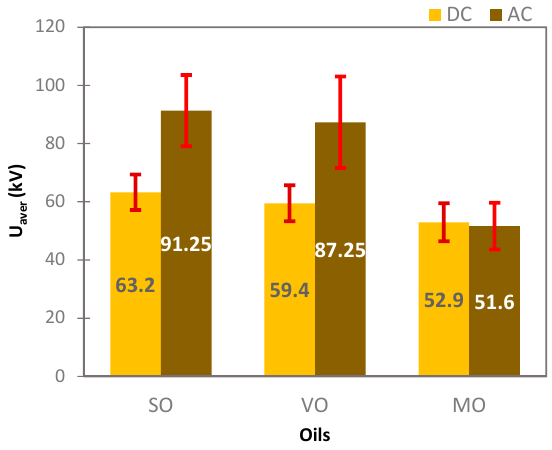
Figure 5. Average breakdown voltage of oils alone; the bars indicate the standard deviation.